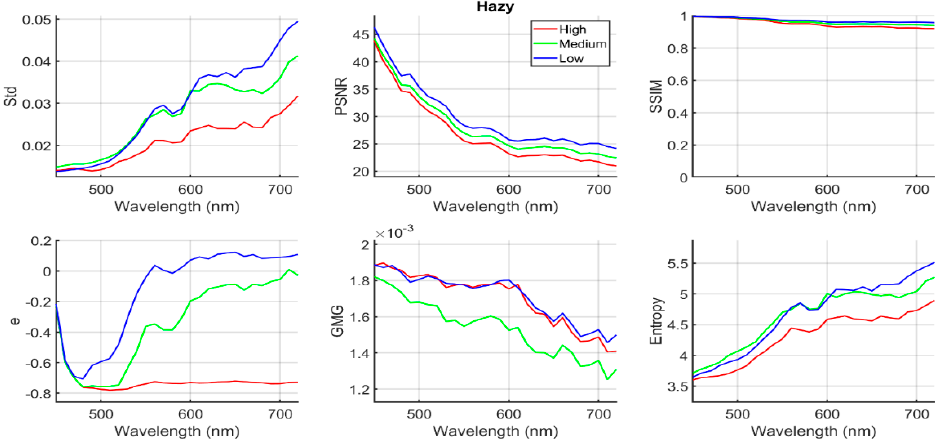
Figure 4. Quality metric values for the hazy images corresponding to low (blue), medium (green) and high (red) haze conditions, in the full wavelength range from 450 nm to 720 nm.